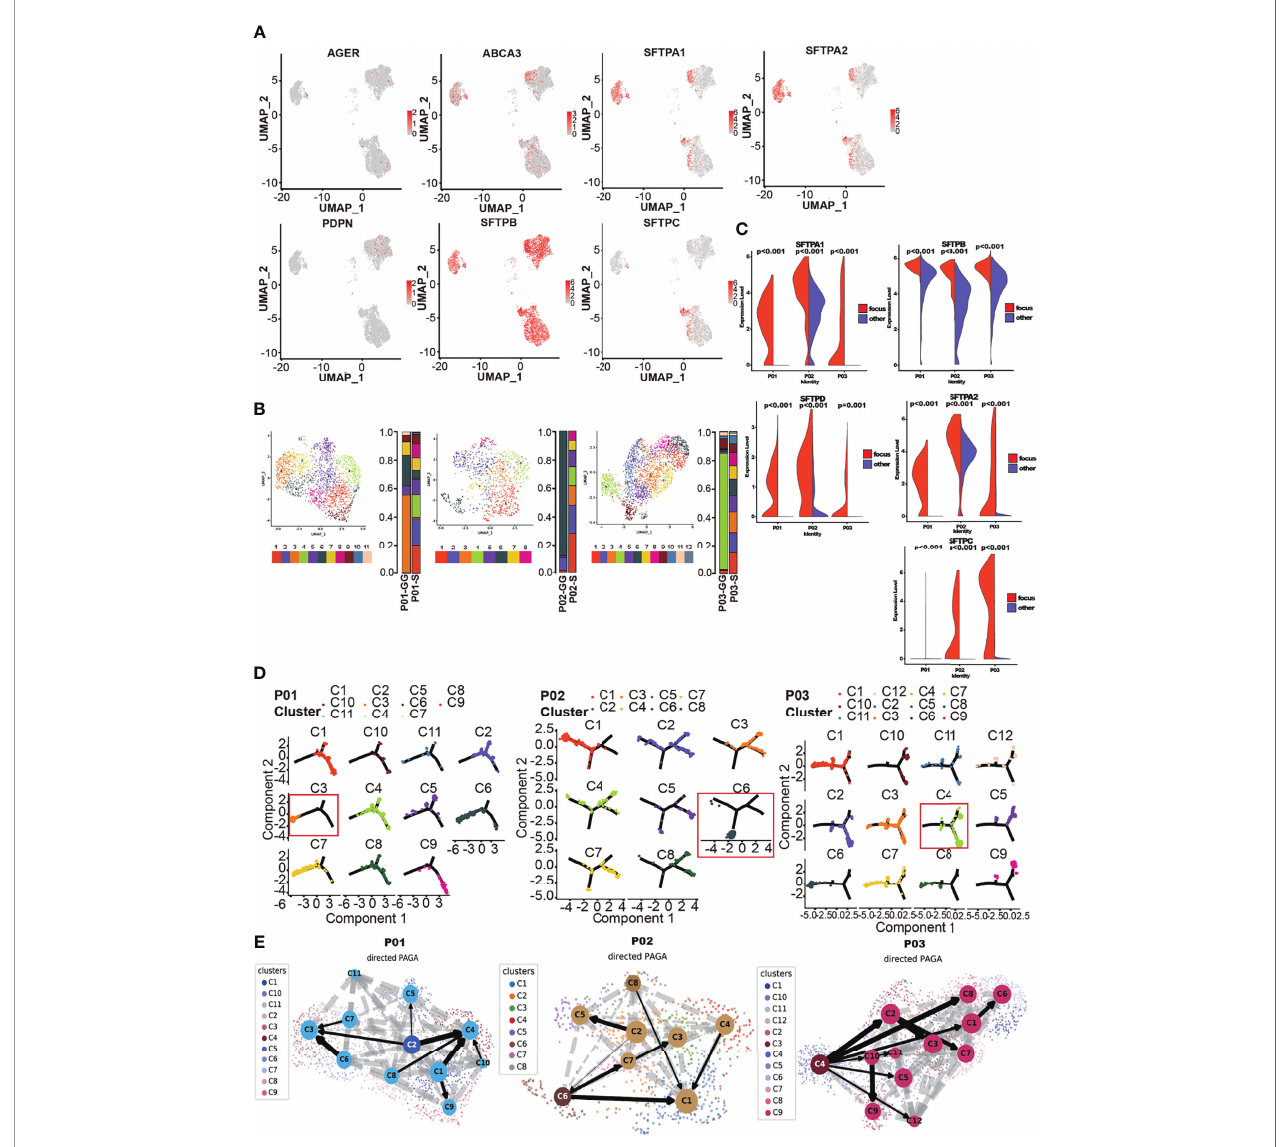
FIGURE 3 | Origin of cancer cells in solid part of mGGO. (A) The gene plot of published AT1 (AGER and PDPN) and AT2 (ABCA3, SFTPA1, SFTPA2, SFTPB, and SFTPC) markers expressed in cancer cells; red dots are cells that expressed these genes. (B) Subclustering of cancer cells by each patient; each color represents a subcluster of cancer cells, and the proportion of each subcluster is displayed on the bar graph on the right. (C) The violin plot reveals differential expression of surfactant family between ground-glass (GG) and solid (S) components growth privilege cancer subcluster (labeled as focus) and other clusters (labeled as other). Wilcoxon rank-sum test was used for analysis. (D) The UMAP visualization of cancer subclusters trajectory used monocle by sample. Each subcluster is plotted individually, and the red box marks the GG/S component growth privilege cancer subcluster. (E) The PAGA embedded with RNA velocity reveals the possible trajectory of cancer subclusters. Subclusters highlighted with darker node backgrounds are the assuming origin cluster based on RNA velocity. mGGO, mixed ground-glass opacity; UMAP, Uniform Manifold Approximation and